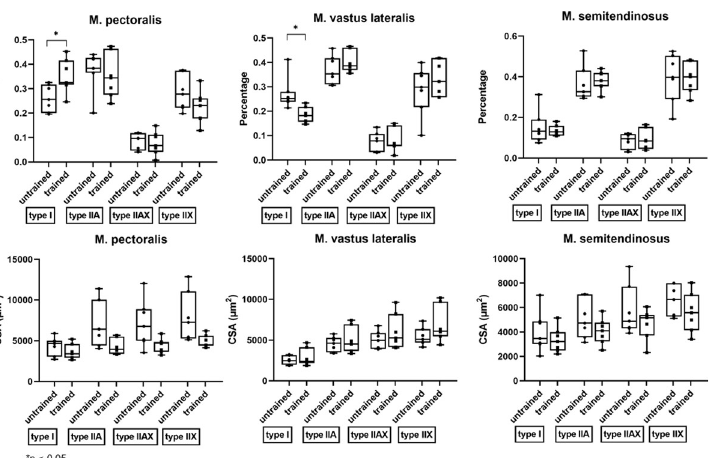
Fig 8. Effect of dry treadmill training on muscle fiber type composition and cross sectional area (CSA). Effect of 8 weeks of DT on muscle fiber type composition and CSA of the different muscle fibers was measured in the M. pectoralis, M. vastus lateralis and M. semitendinosus at rest in unconditioned state (untrained) and after 8 weeks of DT (trained) in Friesian horses.